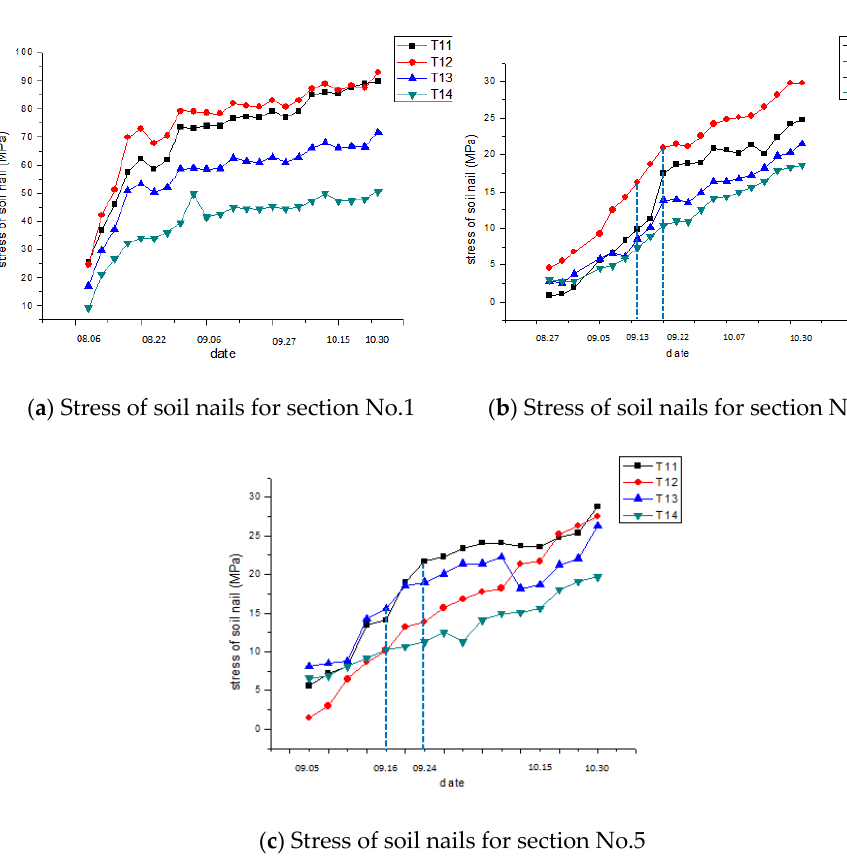
Figure 11. Stress–date relationship of the first row of soil nails for testing sections.